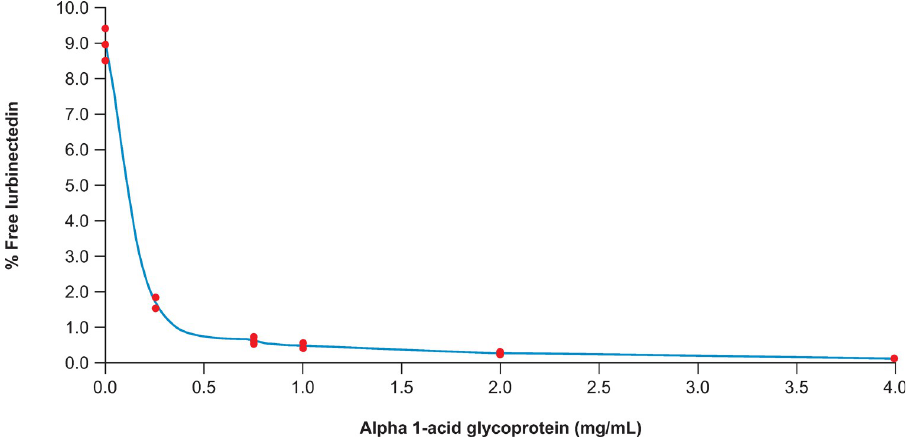
Fig 6. Lurbinectedin plasma protein binding in artificial plasma with varying alpha-1-acid glycoprotein levels.